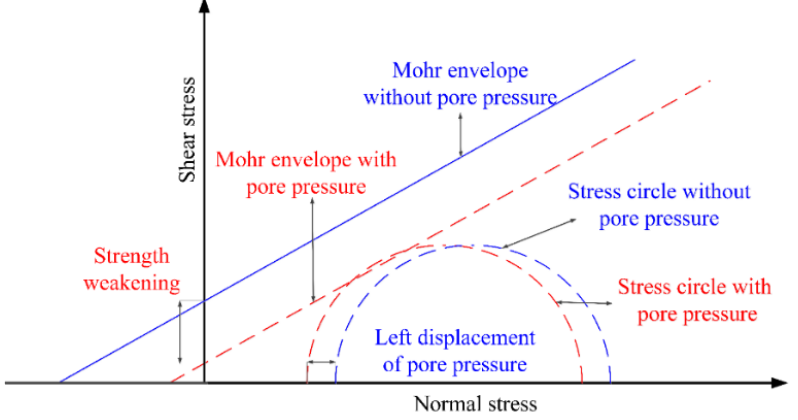
Figure 18. Relationship curve between shear stress and normal stress with and without pore pressure.